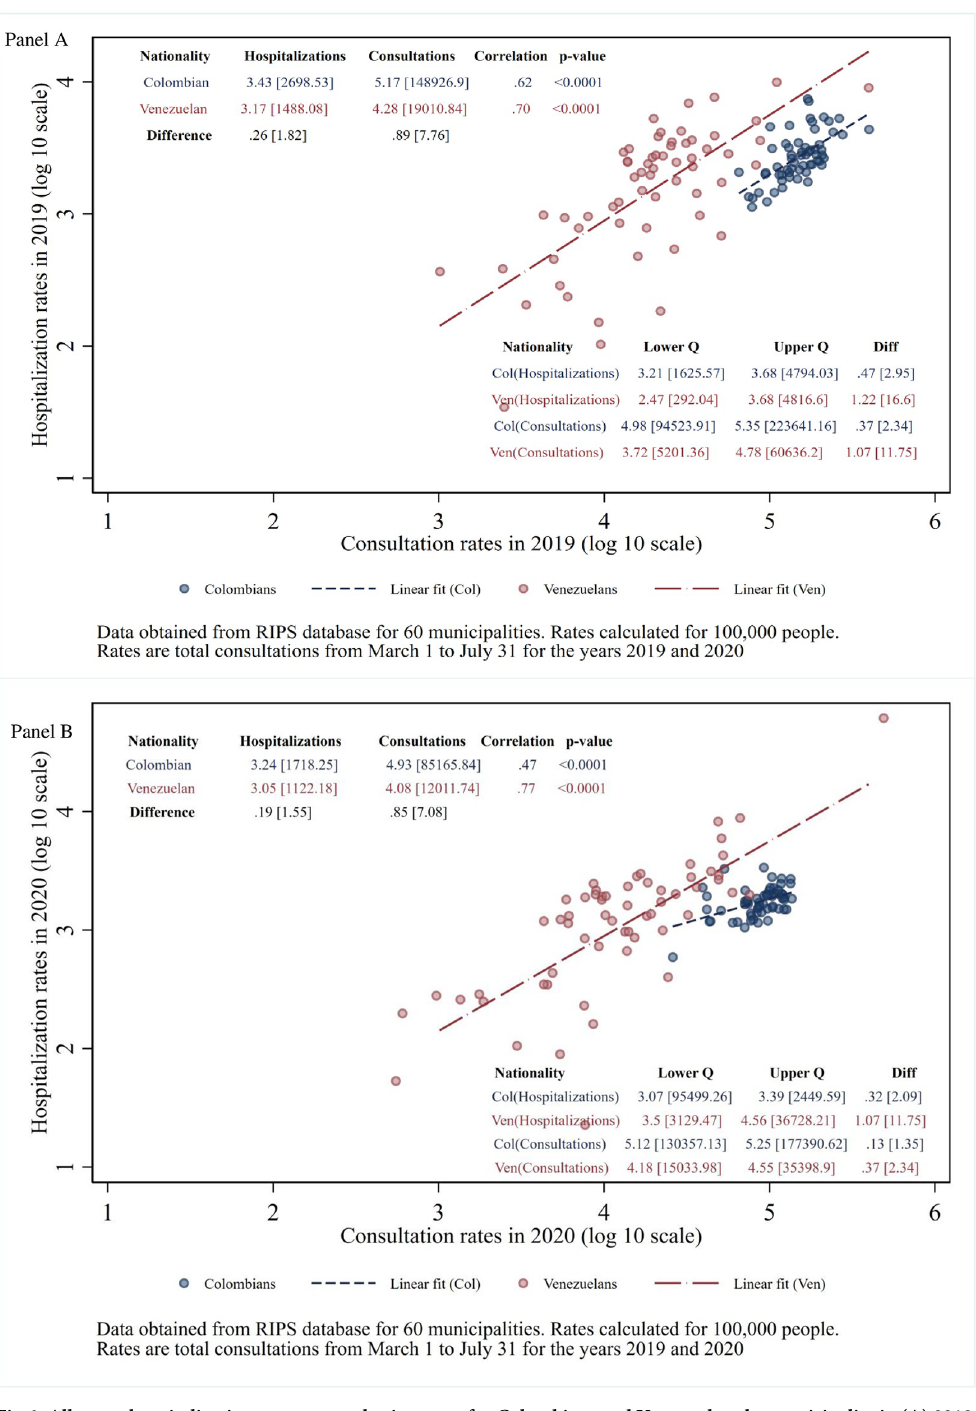
Fig 6. All-cause hospitalization versus consultation rates for Colombians and Venezuelans by municipality in (A) 2019 and (B) 2020.